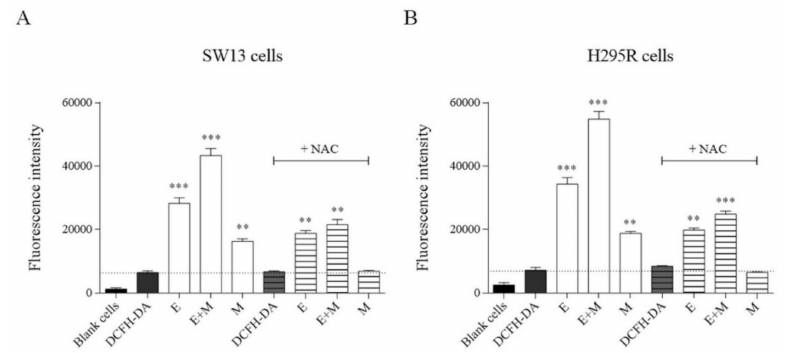
Figure 8. Histograms of intracellular levels of reactive oxygen species in SW13 ( A ) and H295R ( B ) cells after treatment with EF24, mitotane, and their combination. DCFH-DA = 2 (cid:48) ,7 (cid:48) -dichlorofluorescein diacetate. NAC = N-acetil-cysteine. E = EF24. M = mitotane. E + M = EF24 + mitotane. Treatment vs. control: ** p < 0.01, *** p < 0.001. Experiments were performed in triplicate and repeated